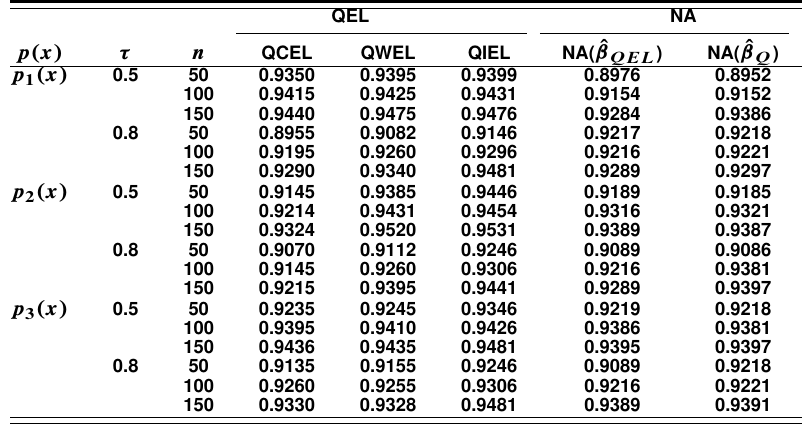
Table 2. Emprical coverage probabilities of the intervals for ˇ in Model 1 for different forms of the selection probability function p.x/ and different values of the sample sizes n and the quantile level (cid:28) under the nominal level 0.95.